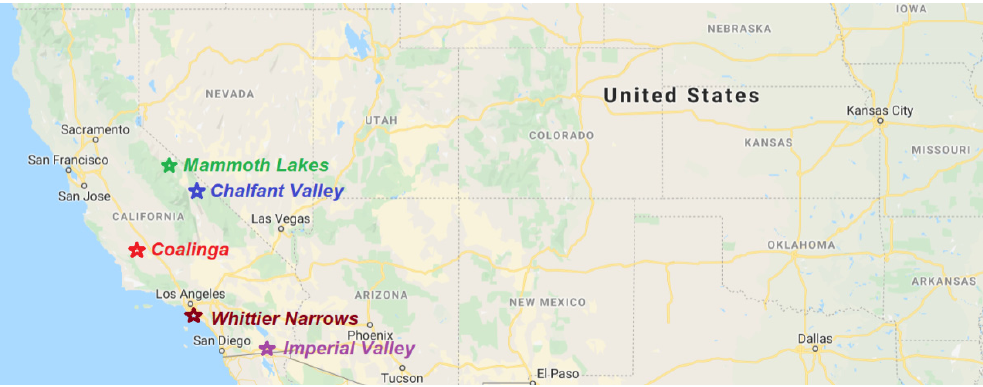
Figure 3. Map of earthquakes under consideration.